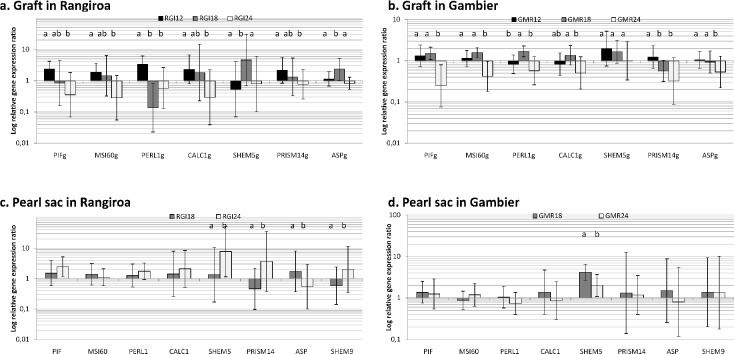
Relative gene expression ratio of biomineralisation genes in P. margaritifera.Relative expression of 7 genes in the saibo at Rangiroa (a) and Gambier (b) for donors aged 12, 18 and 24 months (dark to light grey). Relative expression of 8 biomineralization genes in the pearl sac in Rangiroa(c) and Gambier (d) for donors aged 18 and 24 months (dark and light grey, respectively). Y axes are in logarithmic scale. Error bars correspond to standard deviations. Statistical differences between the age groups are indicated by letters (p < 0.05). Datas available on S2 Appendix.